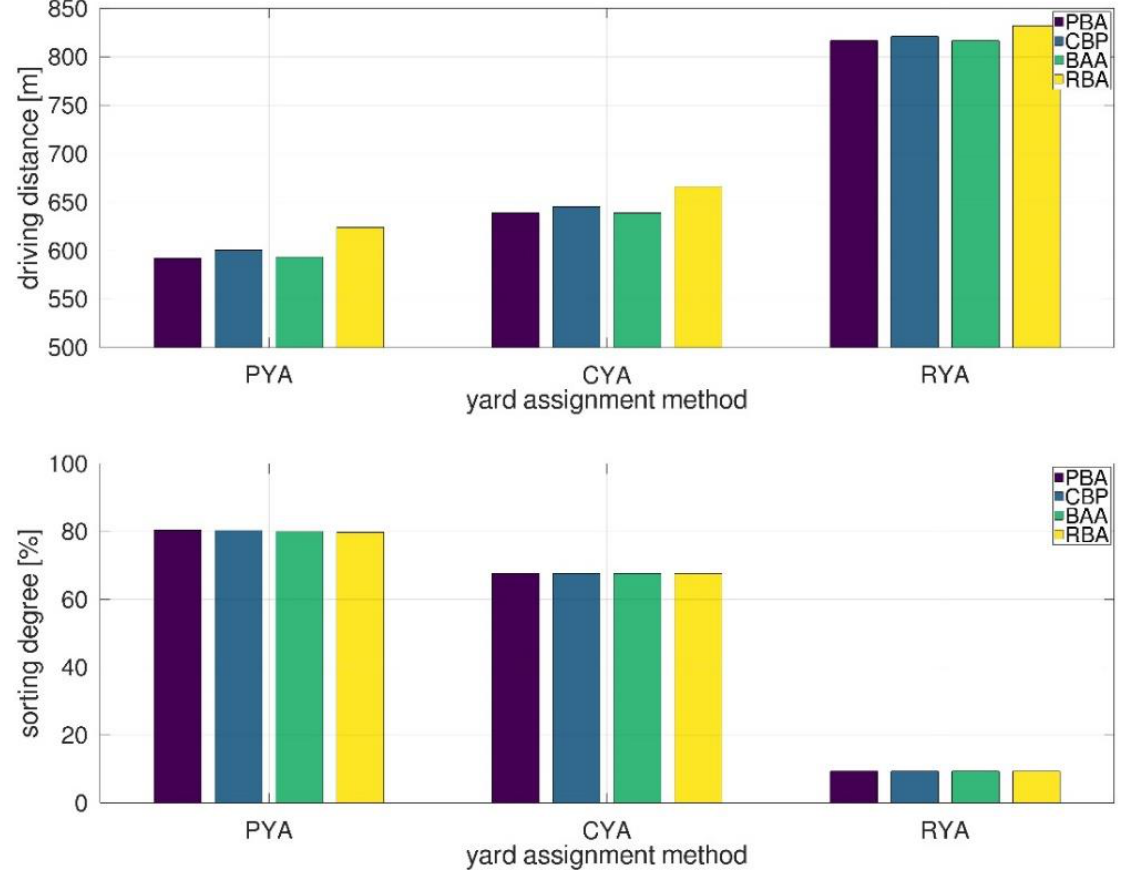
Figure 5. Driving distances and sorting degrees for yard and berth methods.